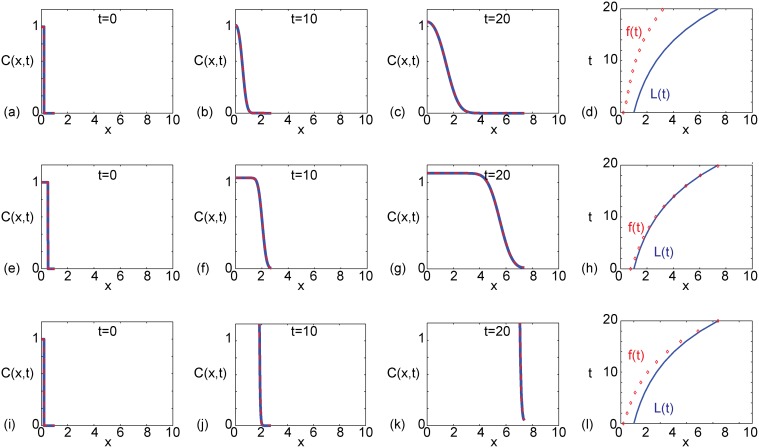
Comparison of exact solutions and numerical approximations for different values of β and k.All results correspond to an exponentially-elongating domain, L(t) = L(0)exp(αt), with L(0) = 1 and α = 0.1. The initial condition is given by Equation (5) with C
0 = 1, and in all cases we set D = 1 × 10−3. Results in (a)–(d) correspond to a narrow initial condition, β = 0.2, with k = 0.105. Results in (e)–(h) correspond to a wide initial condition, β = 0.75, with k = 0.105. Results in (i)–(l) correspond to a narrow initial condition, β = 0.2, with k = 1.705. For each set of parameter combinations we show the solution at t = 0,10 and t = 20, as indicated. The exact solutions, presented in (a)–(c), (e)–(g) and (i)–(k) (solid blue), correspond to Equation (13), where we truncate the infinite sum after 1000 terms. The numerical solutions, presented in (a)–(c), (e)–(g) and (i)–(k) (dashed red), correspond to are numerical approximations of Equation (7) with δξ = 0.001 and δt = 0.001. The space–time diagrams summarising the time evolution of the length of the domain, L(t), and the position of the front of the C(x, t) density profile, f(t), given in (d), (h) and (l), are constructed by defining f(t) to be the position where C(x, t) = 0.01.